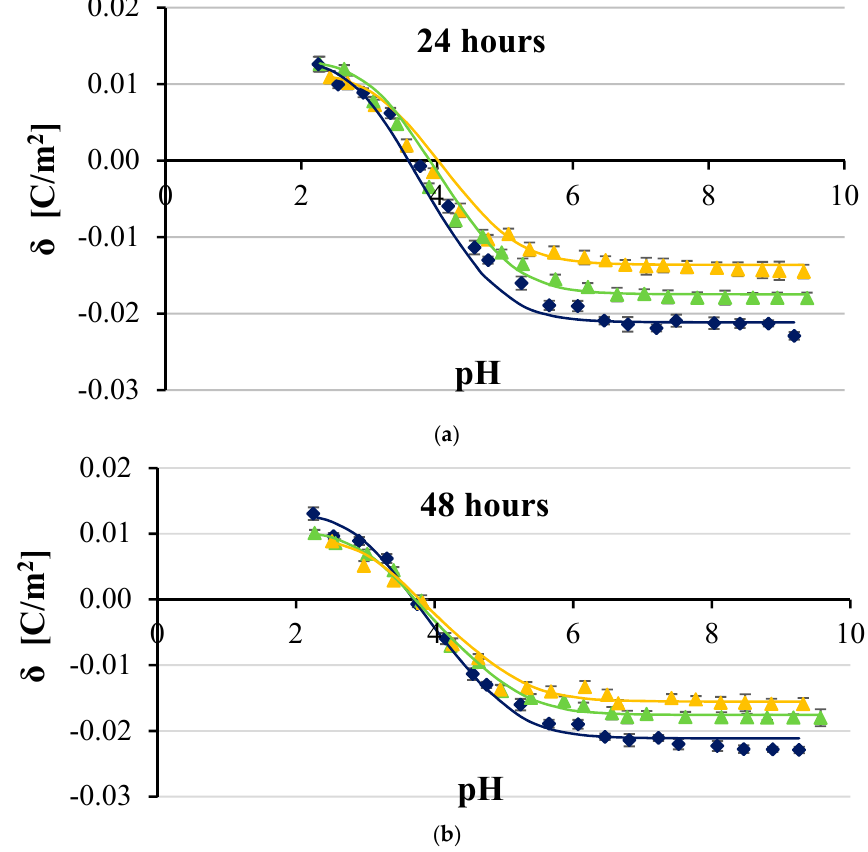
Figure 3. Dependence of surface charge density of glioblastoma LN-229 cell line as a function of the pH of the electrolyte solution. The cells were untreated (navy blue) or treated with 5 (green) and 8 (orange) mmol / dm 3 of p-coumaric acid for 24 h ( a ) and 48 h ( b ). Solid lines describe theoretical values; experimental data are marked by